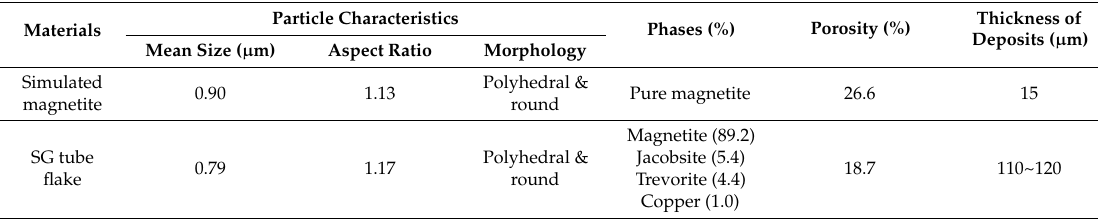
Table 3. Comparative analyses between real steam generator (SG) tube flake and simulated magnetite